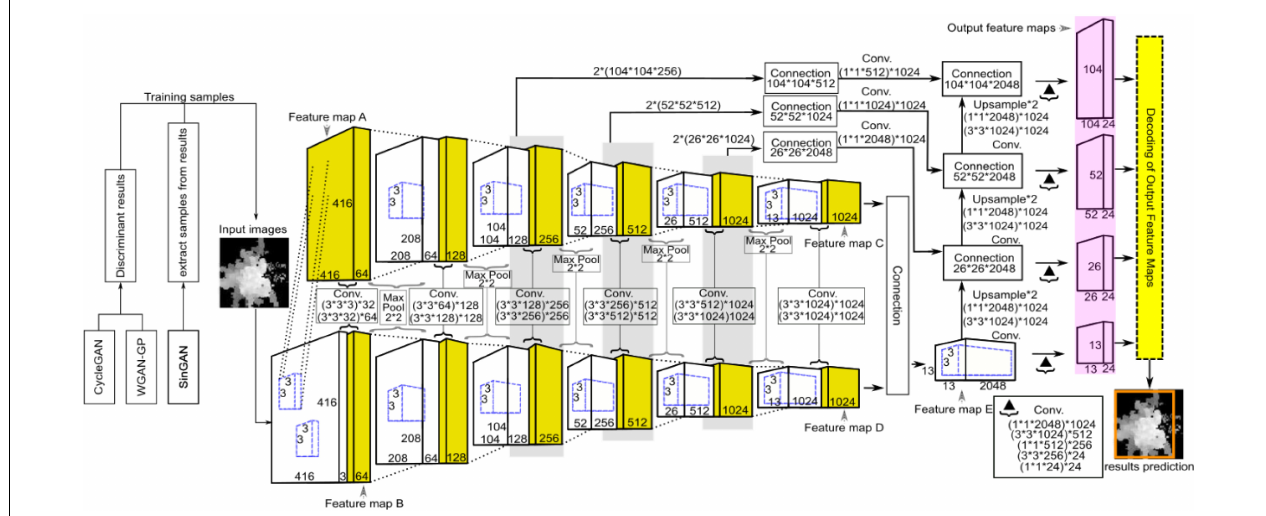
FIGURE 8 | Schematic diagram showing the network structure of YOLO for ITC segmentation, where CycleGAN, WGAN-GP, and SinGAN were used for training data argumentation. YOLO was adopted for ITC detection from the heightmaps of the studied forest canopy.